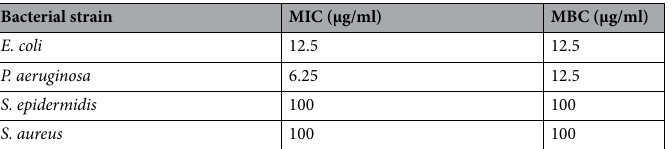
Bacterial strain